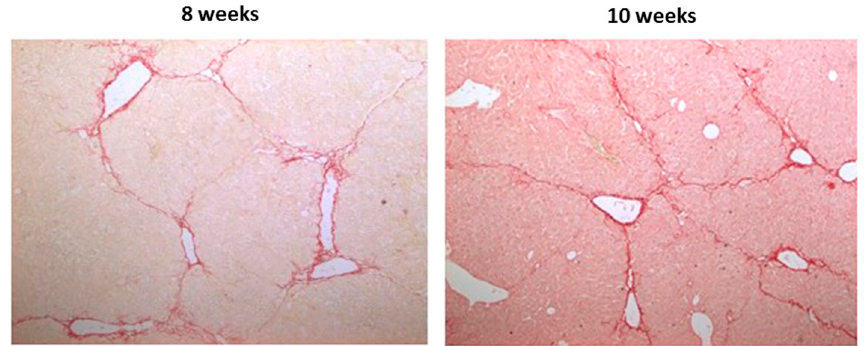
Figure A1. TAA-induced liver fibrosis in mice before and after withdrawal of the insult. Mice were administered TAA intraperitoneally for 8 weeks. Initially, mice were administered with 100 mg TAA/kg body weight, followed by 10% weekly increments to the utmost dose of approximately 200 mg TAA/kg body weight. Thereafter, mice were not treated with TAA for 2 weeks (10 weeks in total). Collagen deposition was visualized by collagen fibers stained with Sirius red.